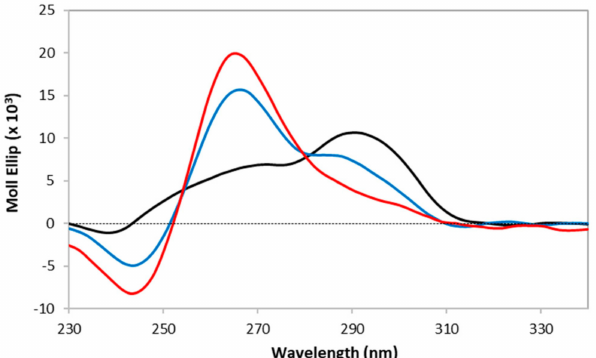
Figure 4. CD spectra of 5 µ M hTel22 alone (black line), after the addition of 2 eq. of PE2Cu , left to equilibrate at room temperature for 16 h (blue line), and after the hTel22 G4 folding in the presence of 2 eq. of PE2Cu (red line) in 10 mM lithium cacodylate buffer at pH 7.4 with 100 mM KCl.